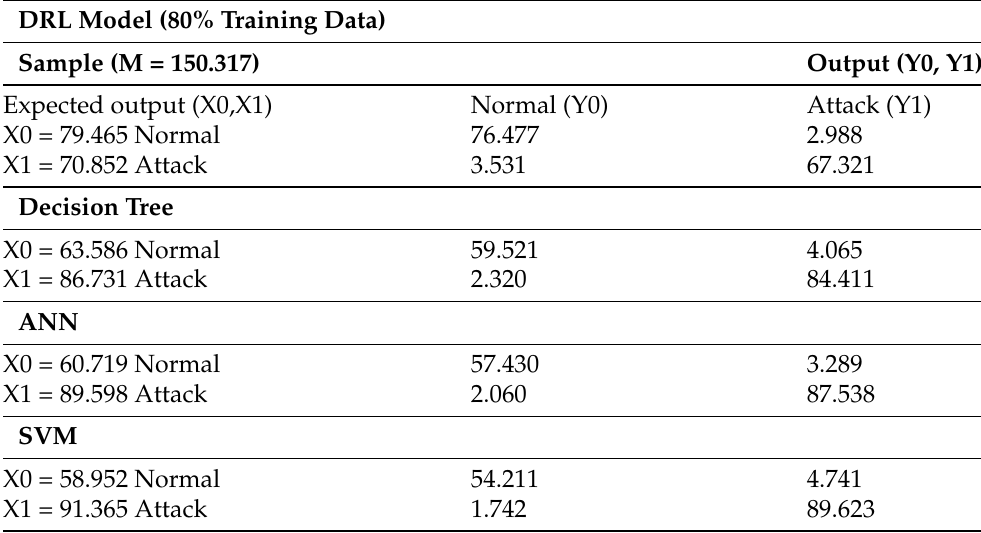
Table 4. Blockchain-based smart home using a DRL training set records during